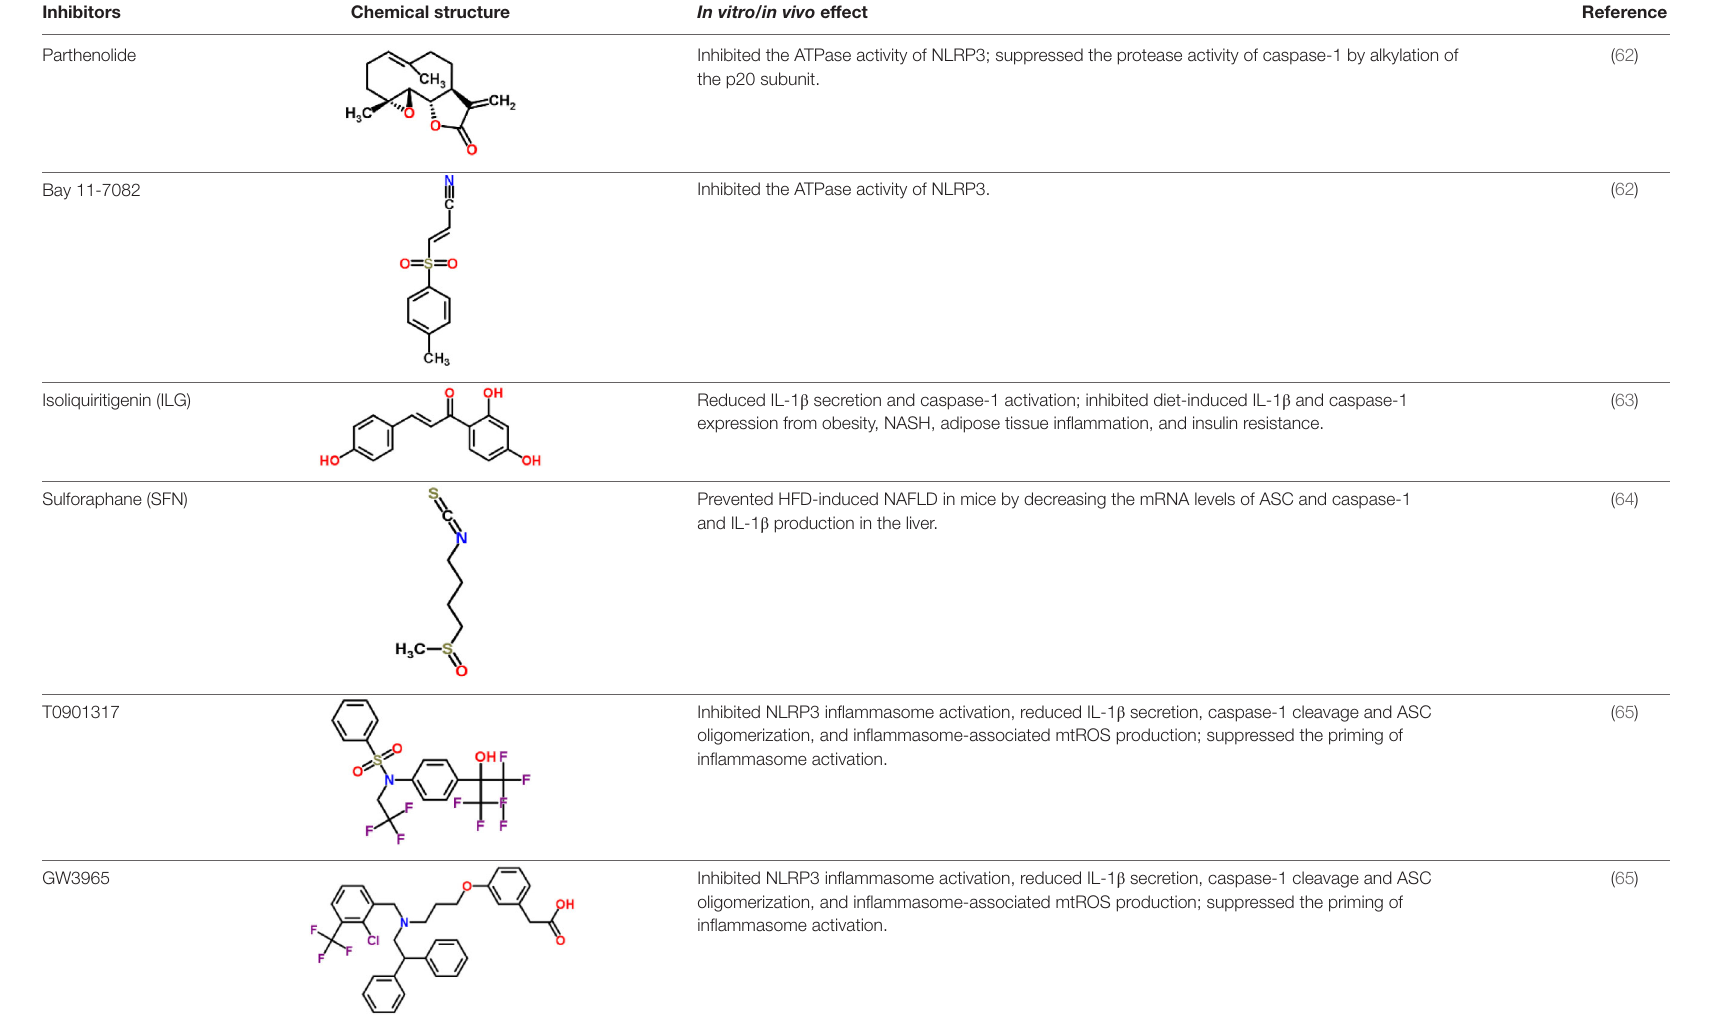
TABLe 1 | Pharmacological inhibitors of the NLRP3 inflammasome signaling